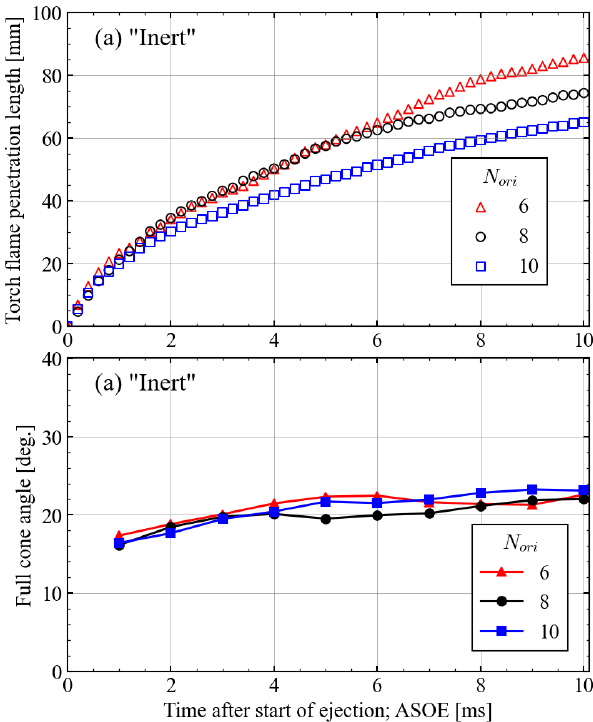
Fig. 9. Time history of (a) penetration, and (b) cone angle of the different number of orifices (N ori = 6, 8, 10) under “inert” conditions